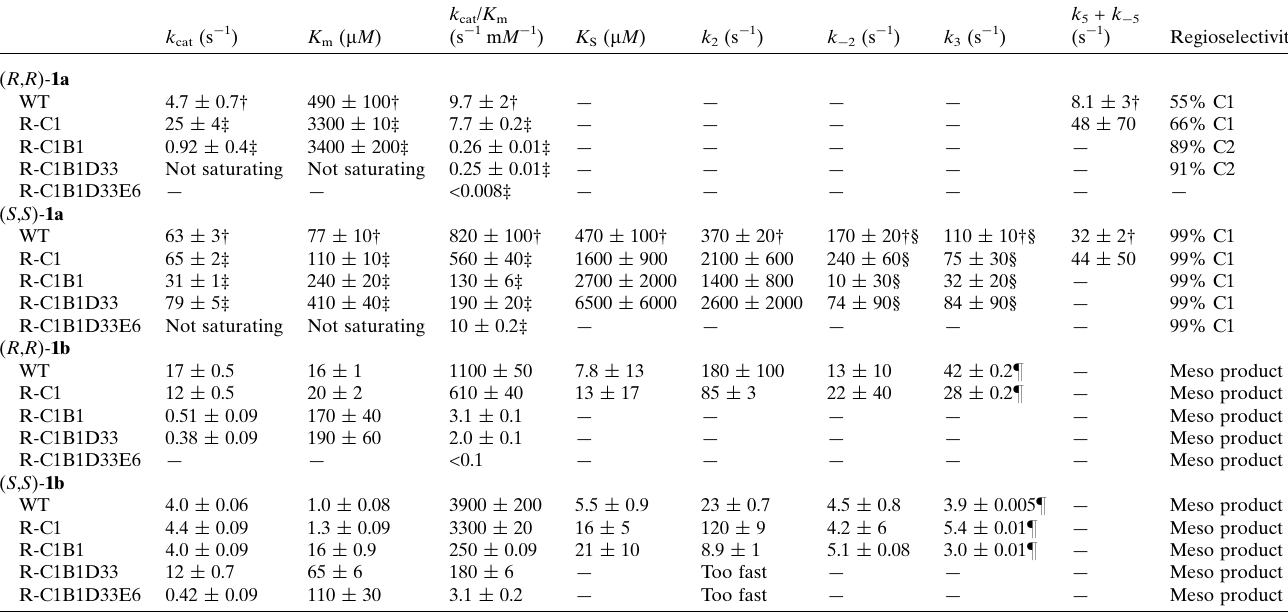
Table 1 Kinetic parameters and regioselectivity in the hydrolysis of 1a and 1b . k cat (s (cid:4) 1